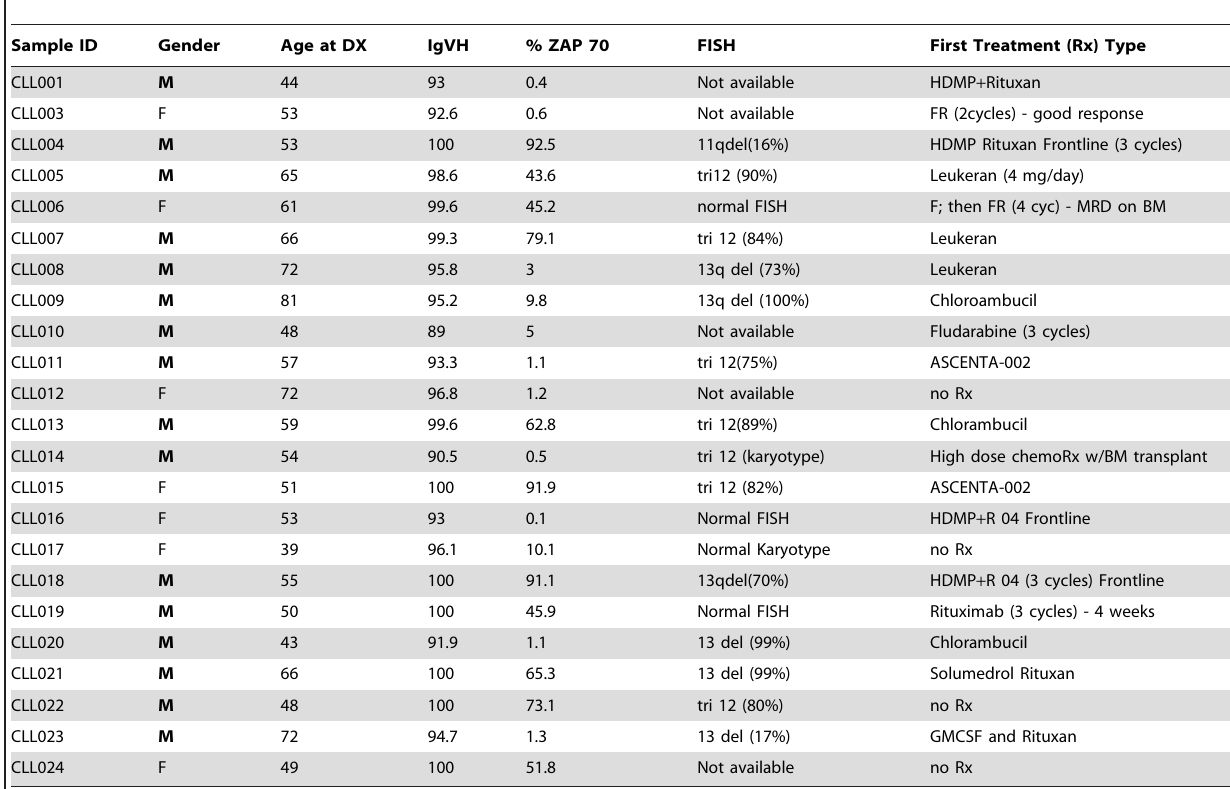
Table 1. Clinical and molecular characteristics of patient